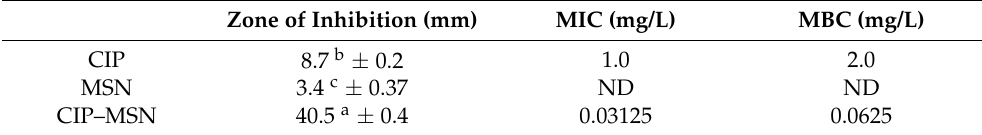
Table 1. Zone of inhibition diameter, MIC, and MBC of ciprofloxacin and MSN particles loaded with ciprofloxacin evaluated by agar well diffusion, and broth microdilution methods for Salmonella typhimurium . Zone of Inhibition (mm) MIC (mg/L) MBC (mg/L) CIP 8.7 b ± 0.2 MSN ND CIP–MSN 40.5 a ± 0.4 0.03125